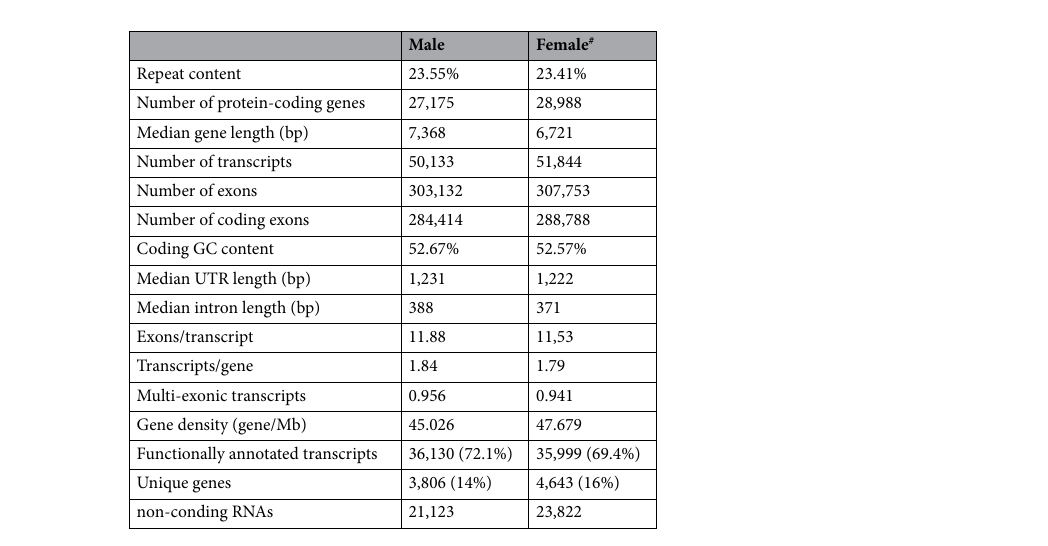
Figure 2. Dot plot comparison of scaffolds (SCF) assembled ( A ) or 21 pseudo-chromosomes ( B ) in the male with respect to SCF in the female. Scale is indicated below.